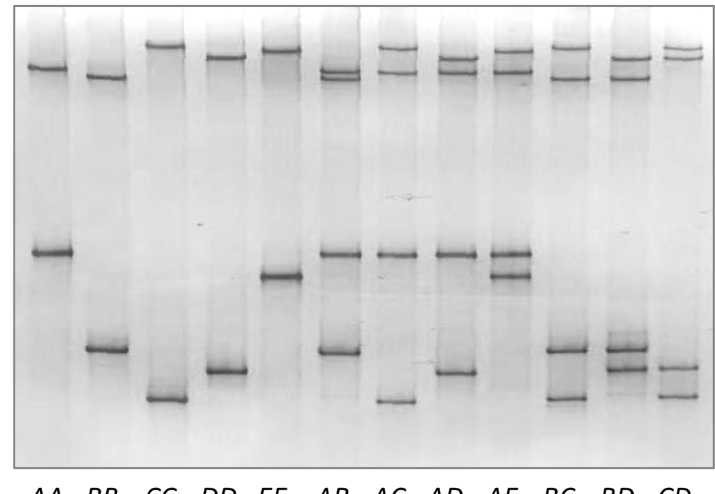
Figure 2. Polymerase chain reaction–single strand conformation polymorphism (PCR-SSCP) analysis of caprine KRTAP6-2 . Five distinct banding patterns representing five different variants ( A , B , C , D , and E ) are shown in either homozygous or heterozygous forms. The entire gel image is shown in Figure S1.